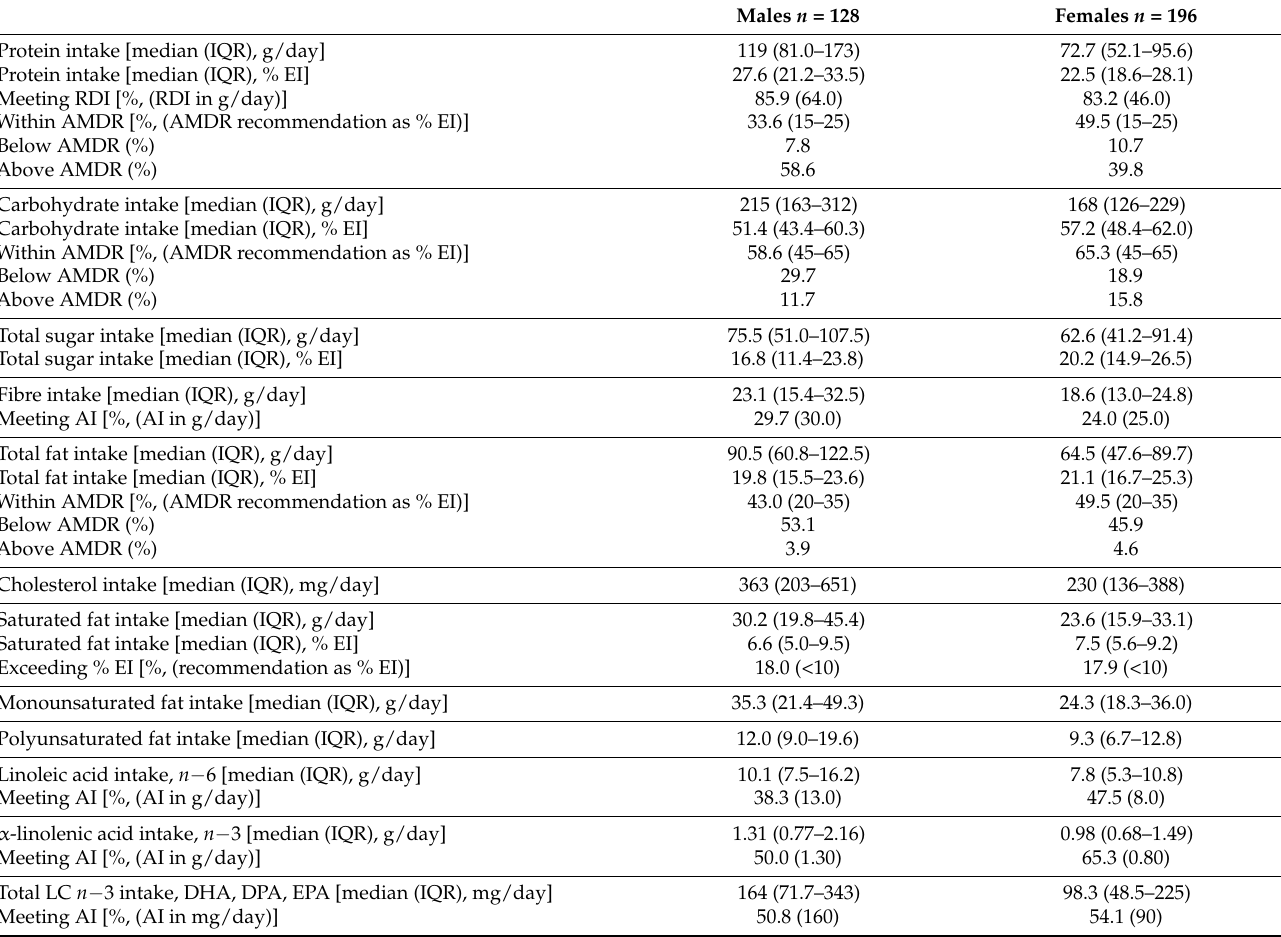
Table 2. Macronutrient intake and current